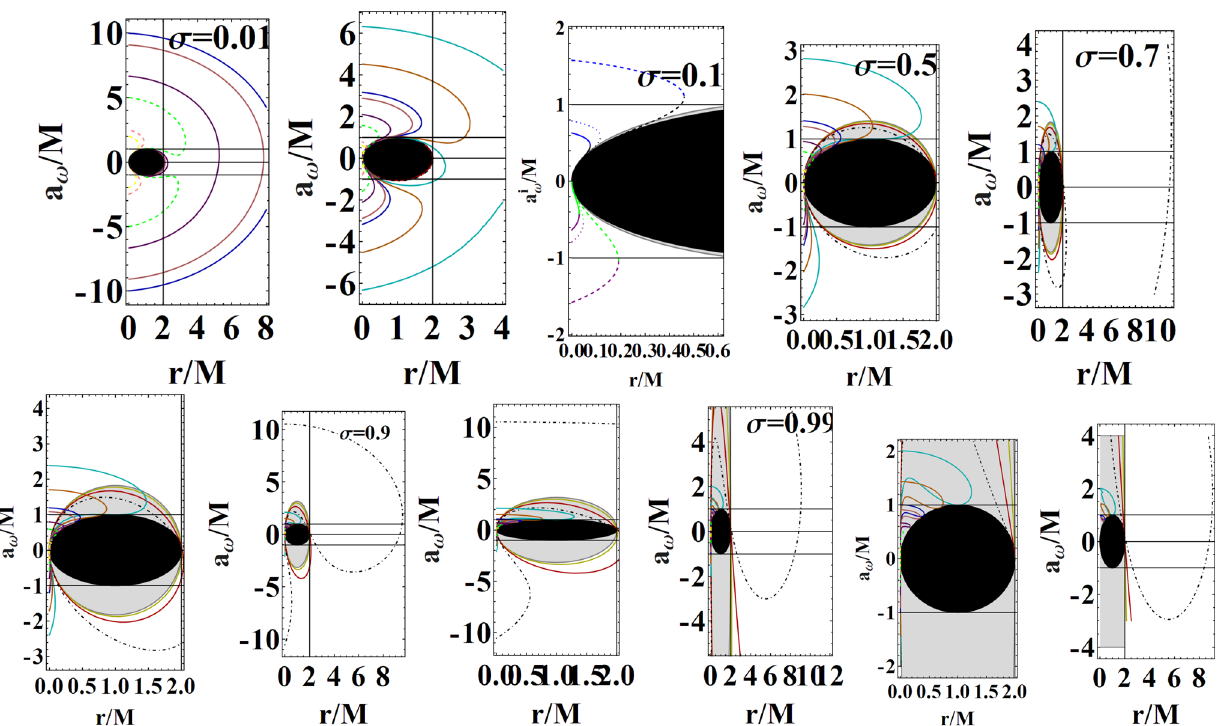
(dashed-pink), 5 (yellow-dashed)}. The black region represents a BH ( a < a ± ) on the extended plane. It follows the analysis of Eq.